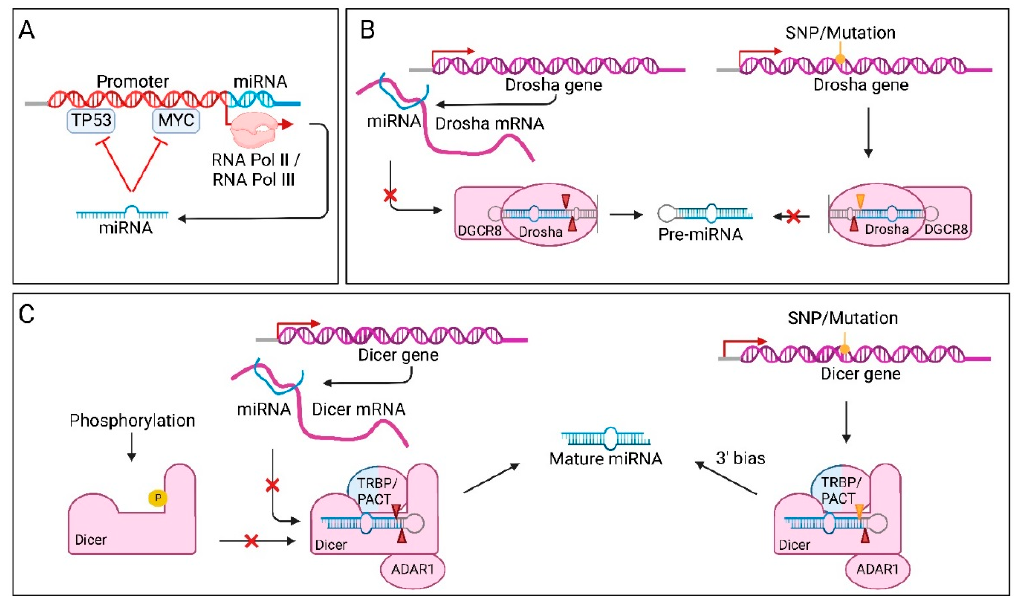
Figure 3. The effect of altered transcription and altered processing through ribonuclease III enzymes Drosha and Dicer malfunctioning. This figure shows how steps of the biogenesis affect production of microRNA (miRNA). ( A ) Often, miRNAs are transcribed by RNA Polymerase II, which requires transcription factors, such as TP53 and MYC. These transcription factors can be targets of the transcribed miRNA, resulting in a feedback loop. ( B ) The Drosha RNase III enzyme processes primary miRNAs to precursor miRNAs (pre-miRNA). The protein’s functionality can be altered by many factors, such as single nucleotide polymorphisms (SNPs) and mutations. Drosha messenger RNA